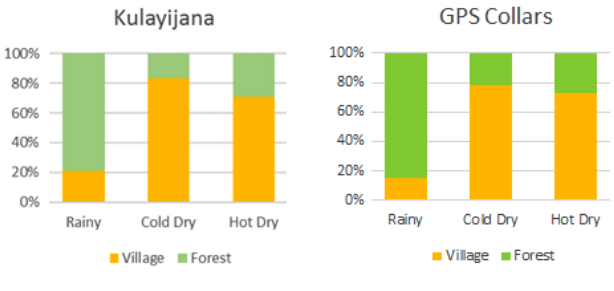
Fig. 6. Use of communal lands and forest estimated using quantitative outputs from playing sessions and independent cattle GPS data. The graphs represent the percentage of time spent by cattle in the communal land (Village) and in the protected area (Forest) for each season. Rainy season = October to May; Cold Dry season= June to July; Hot Dry season = August to September. Left: Estimates from the game were obtained by pooling monthly grazing decisions of 22 players during three playing sessions. Right: Real time spent by cattle was obtained from nine cattle equipped with GPS collars between 2012 and 2014 (Valls-Fox